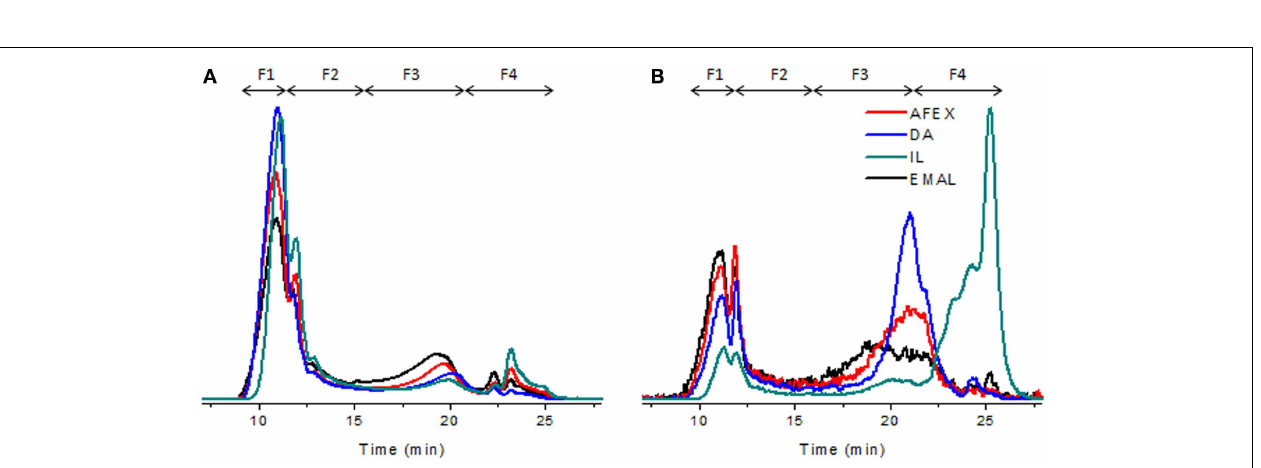
FIGURE 7 |Aromatic region of HSQC NMR spectra of untreated and pretreated corn stover samples .